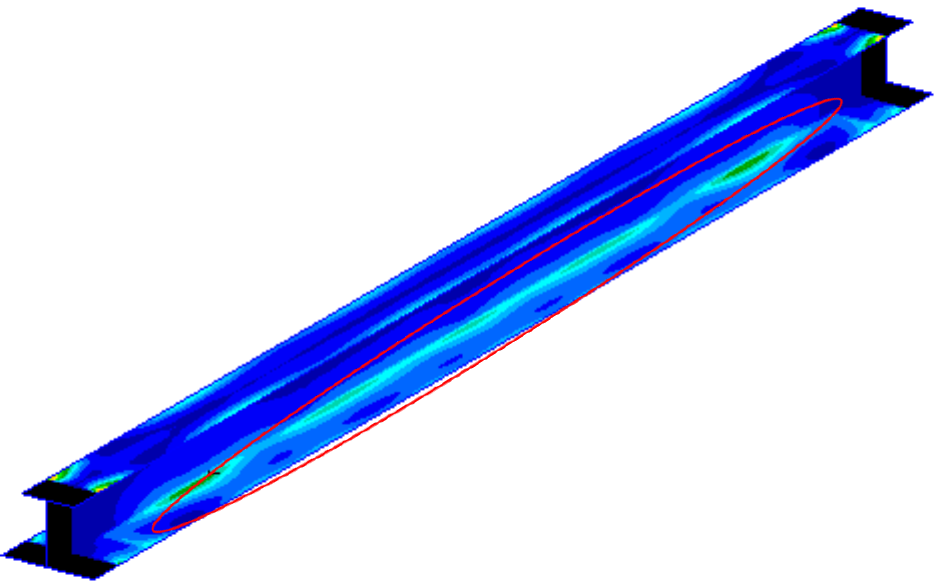
Figure 9. The equal proportion linear summation strain energy of the first 20 modes of the composite beam.